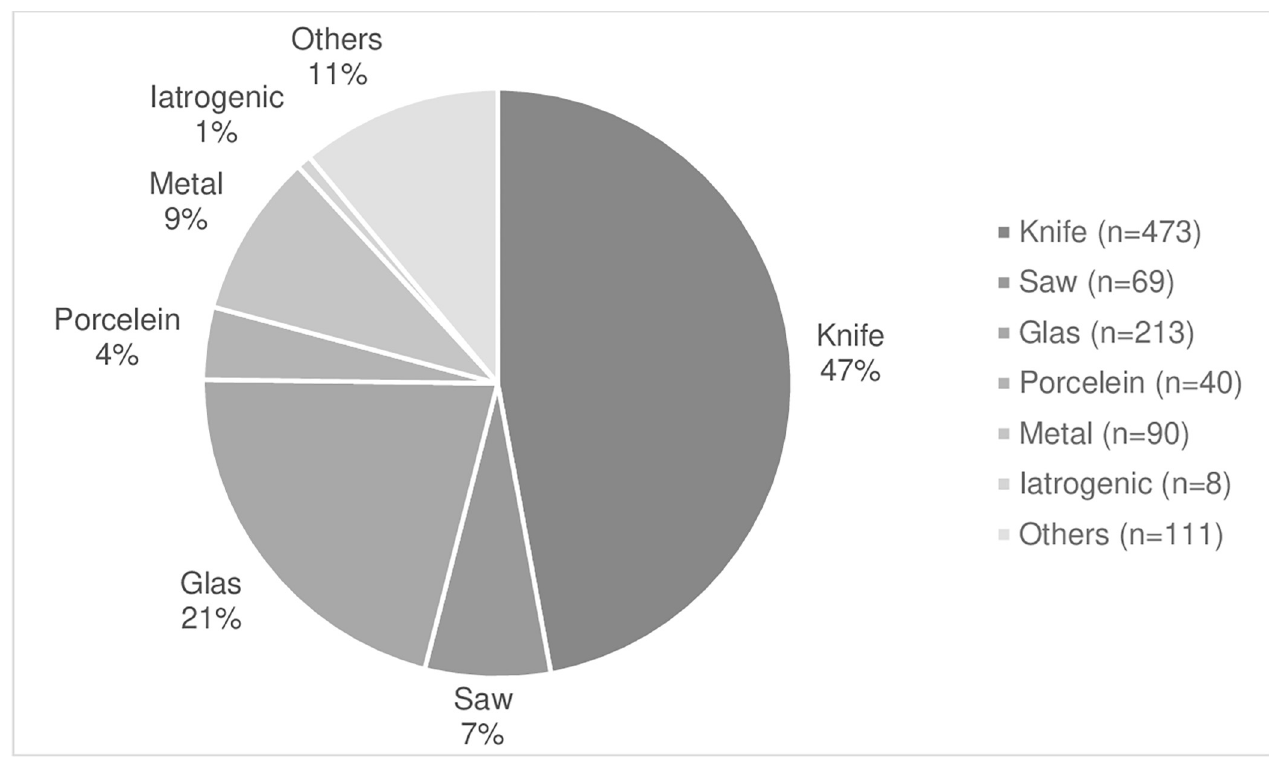
Fig 4. Pie chart presenting cause of